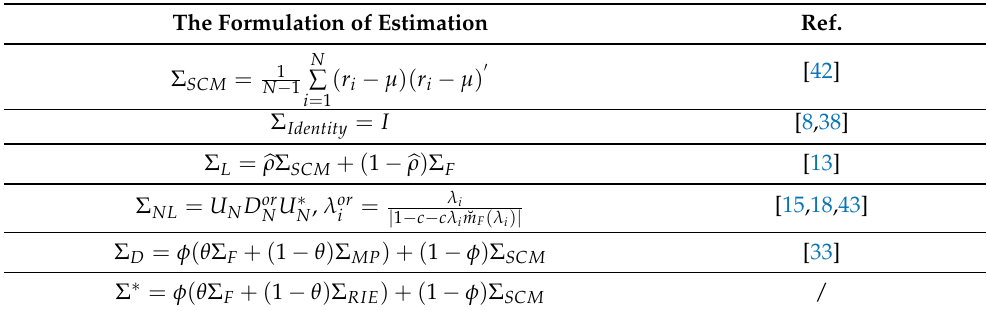
Table 2. The estimators for comparison. The Formulation of Estimation